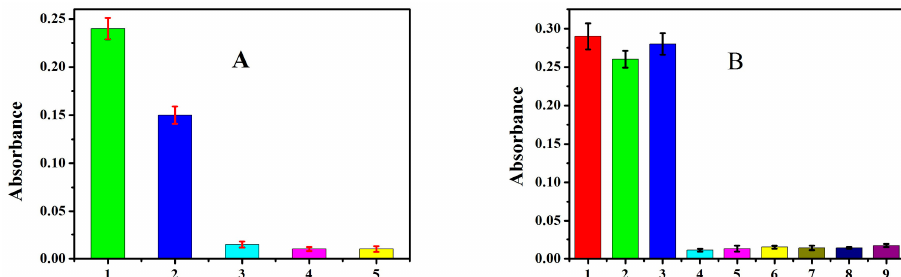
Figure 4. ( A ) Selectivity of the proposed method. (1) T1 (0.2 nM), (2) single-base mismatched target (0.2 nM), (3) two-base mismatched target (0.2 nM), (4) genome of watermelon seedlings (10 ng/ μ L),